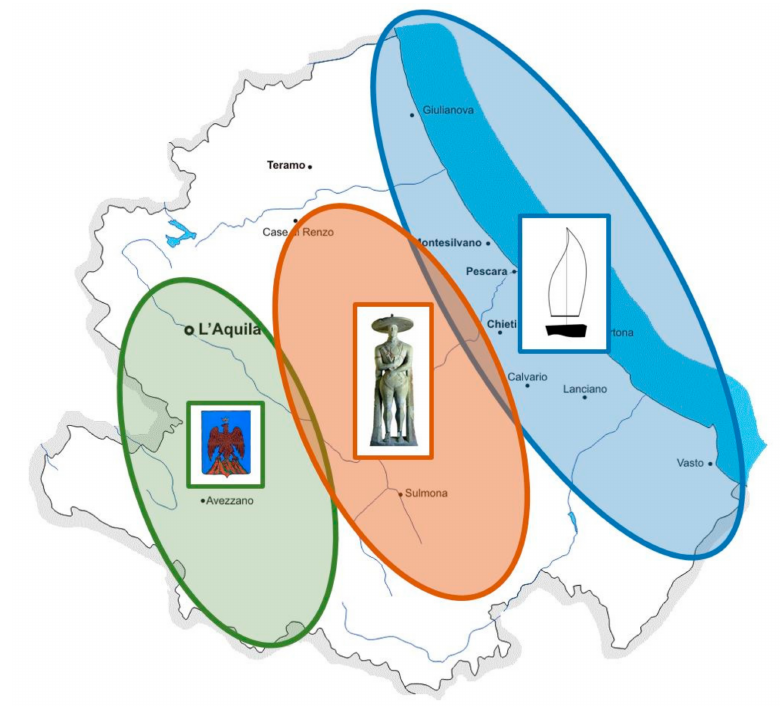
Figure 8. Subdivision by items of